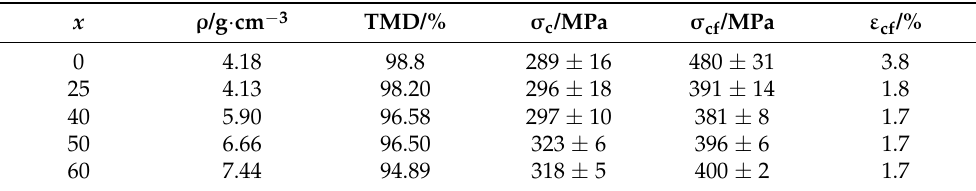
Table 2. Mechanical properties of (48Al–52Ni) 100- x W x